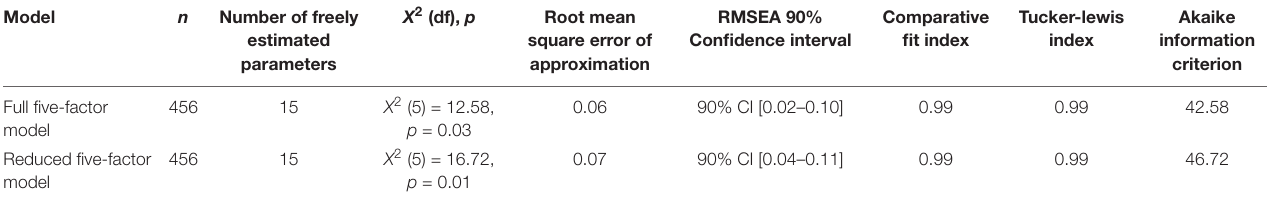
TABLE 5 | Model-fit indices for PR-Comp full versus reduced model.